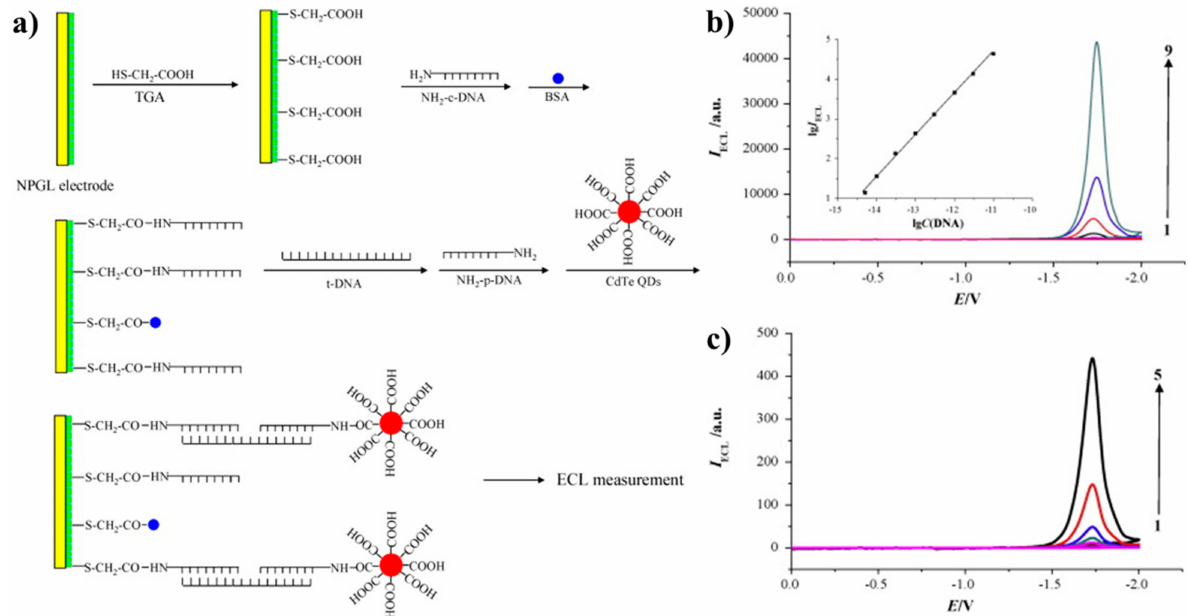
Figure 7. ( a ) Schematics of the process of DNA determination. ( b ) Electro chemiluminescent current (I ECL ) vs. potential (E) curves for the CdTe Quantum dot-labeled DNA hybrids immobilized on the nanoporous gold leaf electrode for different t-DNA concentrations (the inset shows the linear relationship between I m,ECL on the IECL-E curves and the t-DNA concentration). ( c ). A magnified portion of the I ECL -E curve. Reproduced with permission from [47]. Copyright © 2020 Elsevier